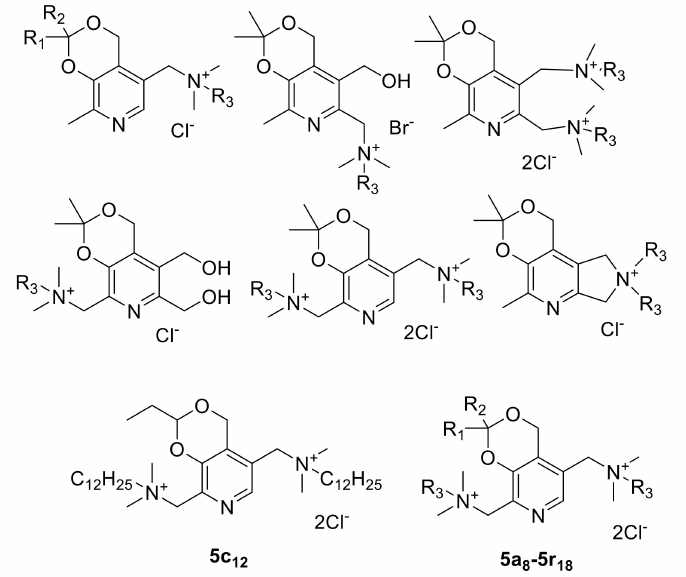
Figure 1. The structures of QAC based on pyridoxine derivatives obtained by us earlier [13–19] and compounds 5a 8 – 5r 18 synthesized in this